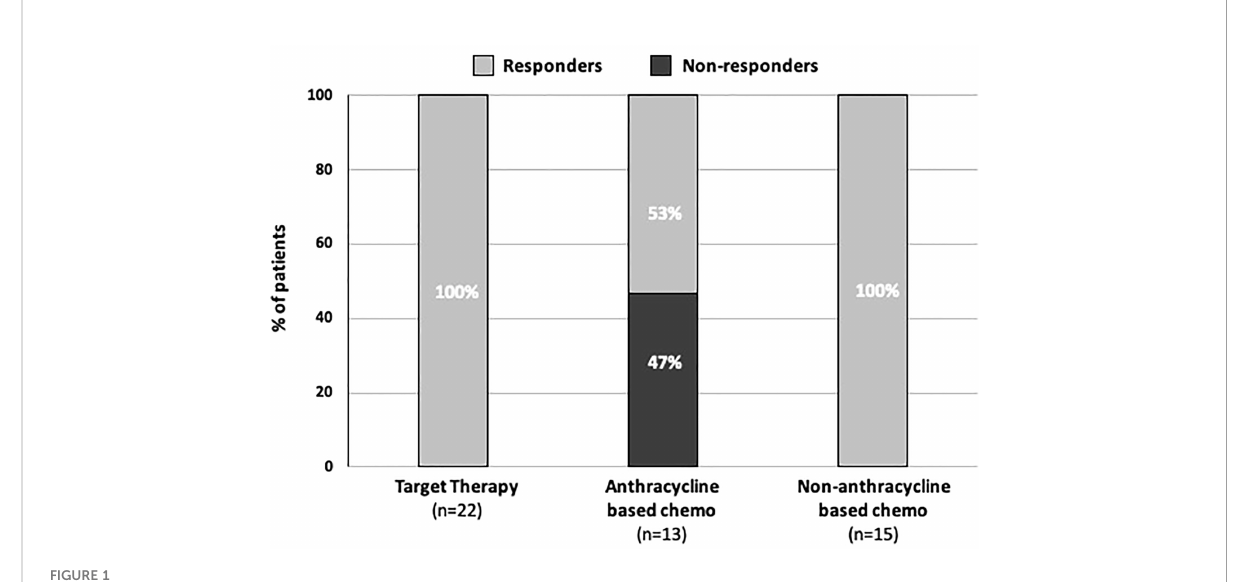
FIGURE 1 Bar graphs showing the seroconversion rate according to treatment.